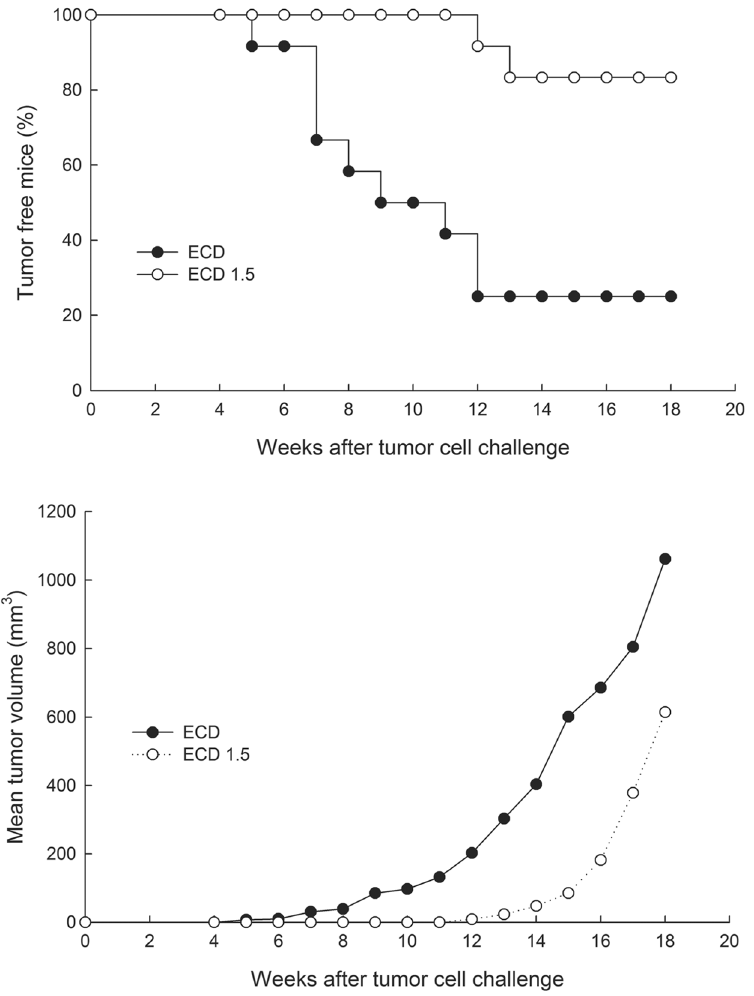
Figure 5. In vivo anti-tumour effect of anti-p185 sera from immunized mice. The capacity of anti-p185neu sera to interfere with the development of p185- overexpressing 202/1 A tumours cells is shown. Sera from 56 week- old ECD or ECD1.5 mice were i.p. injected in 8 weeks-old FVB/N mice (12 mice/group); 24 h after mice were s.c. challenged with N202/1 A tumour cells. Effect of sera from SI or ECD1.5 on tumour incidence (top) or mean tumour volume (bottom) are shown. Difference in tumour incidence, as assessed by the Mantel–Haenszel log-rank test, was significant between ECD vs. ECD1.5 ( p < 0.001). Difference in mean tumour volume was assessed by T